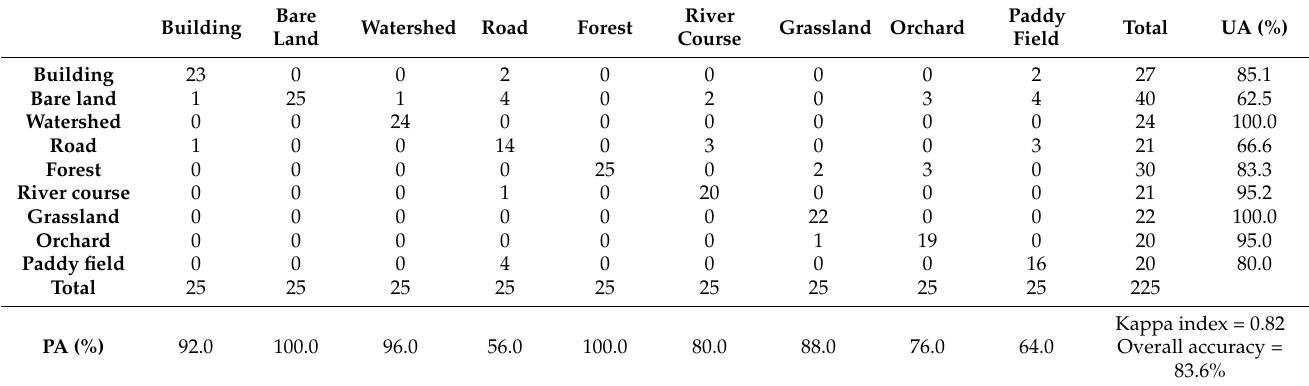
Table 4. Error matrix of satellite imagery interpretation (24 August